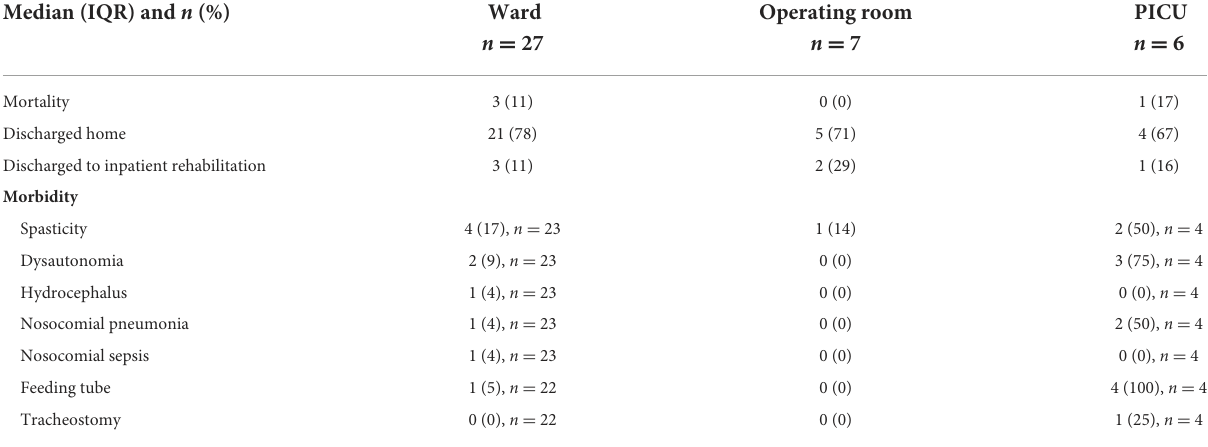
TABLE 4 Inpatient outcomes separated by highest level of care. Median (IQR) and n (%) Ward Operating room PICU